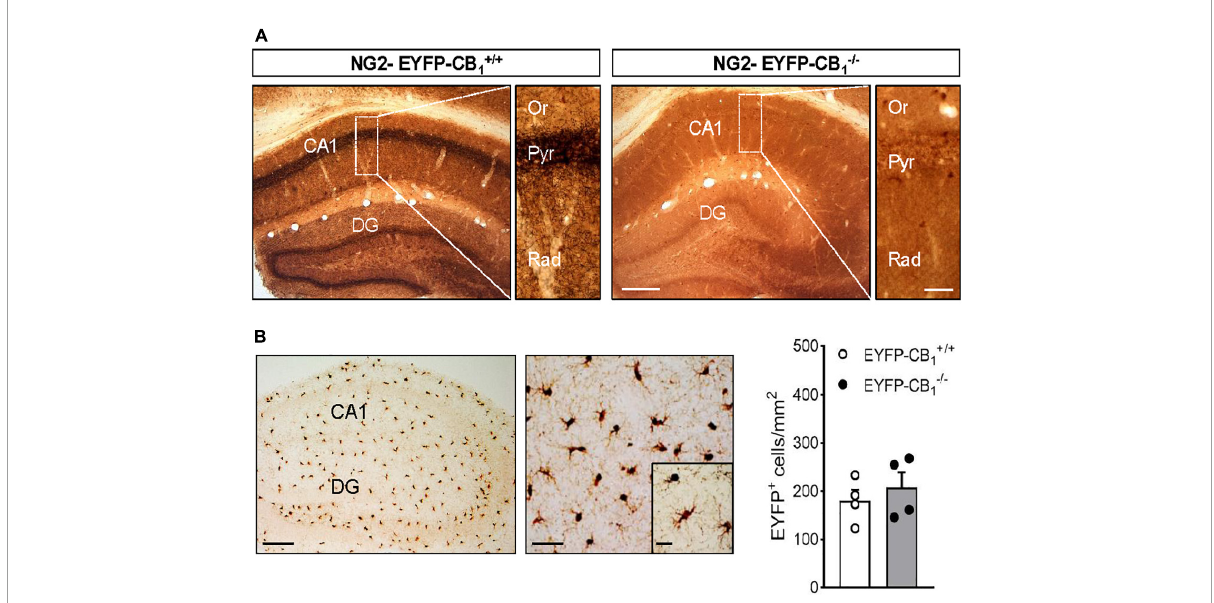
FIGURE1 Combined immunogold and immunoperoxidase for CB 1 and EYFP in the hippocampus of NG2-EYFP mice. (A) Representative images show pre-embedding silver intensified immunogold labeling of CB 1 receptors and immunoperoxidase labeling EYFP in coronal brain sections from NG2-EYFP-CB 1 + / + and NG2-EYFP-CB 1 - / - mice. Intense bands of CB 1 receptor immunostaining are observed in the stratum pyramidale and molecular dentate gyrus. Higher magnification images show dense CB 1 receptor neuropil labeling throughout CA1 stratum radiatum . The hippocampus of a NG2-EYFP-CB 1 - / - mice shows no CB 1 immunopositive profiles and allows visualization of uniformly distributed DAB + NG2 cells (white asterisks). (B) Immunoperoxidase labeling of EYFP in the hippocampus of NG2-EYFP ± -CB 1 + / + mutant mice showing the typical distribution and morphology of NG2 cells in this brain area. Densities of EYFP positive cells in CA1 stratum radiatum were statistically similar between genotypes. CA1, region 1 of cornu ammonis ; Or, stratum oriens ; Pyr, stratum pyramidale ; Rad, stratum radiatum ; DG, dentate gyrus. Scale bars: 200 and 25 µ m (A) ; 200, 50, and 25 µ m (B) .